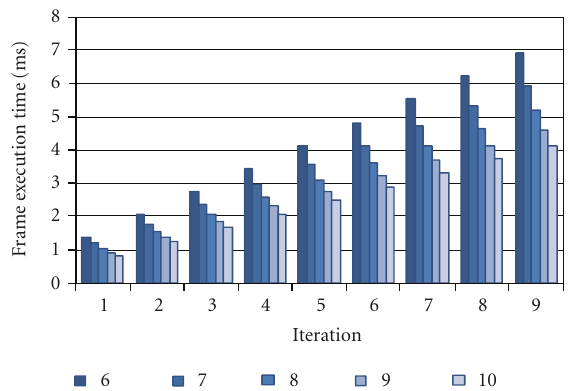
Figure 8: Frame execution time for Caballero is reduced when all the iterations are performed on a slice before next slice is brought in. Figure 9: (a) Consumer and (b) producer cell to node mapping.